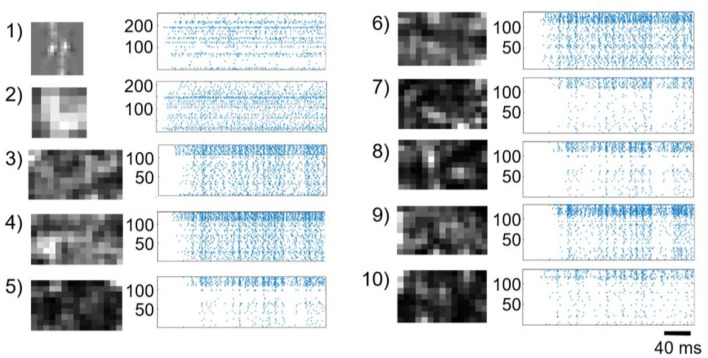
Firing rate and raster plot of each module in the proposed modular reservoir. The raster plot is an example of the network dynamics during learning of the symbol “4” preprocessed using a difference of Gaussian filter. The brightness of the pixels in the maps represents the firing rate of each neuron. As illustrated in Figure 1, the connections between modules are randomly generated to form an acyclic graph using Algorithm 1. The index of each graph indicates the index of the modules shown in Figure 1.